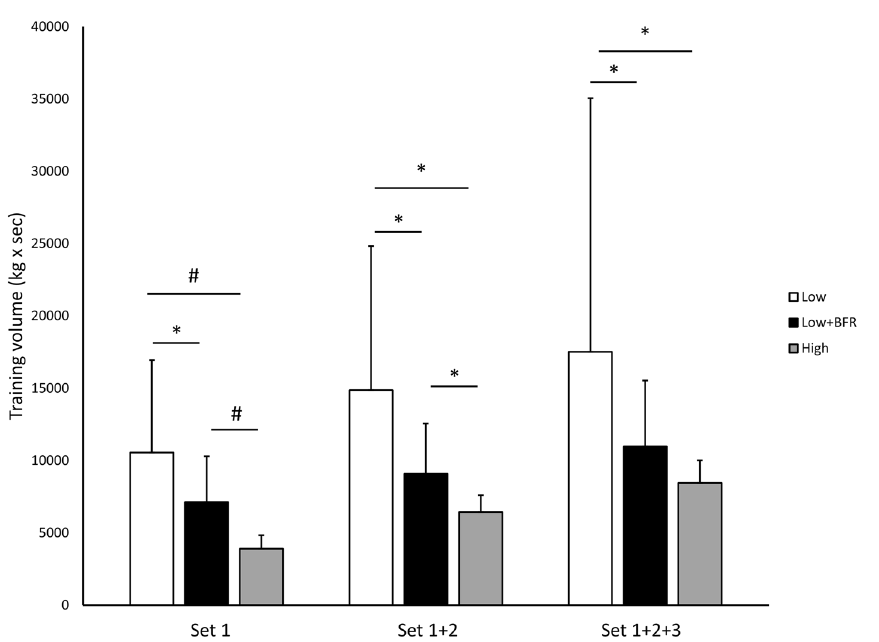
Figure 2. Overview of the study design and finger flexor training